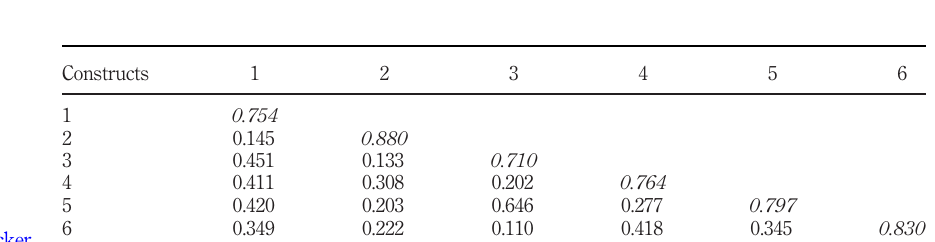
Table I. Reliability tests of